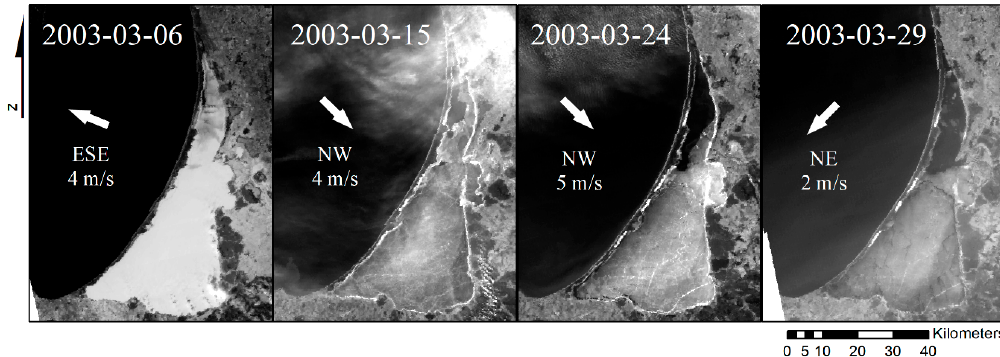
Figure 4. MODIS images of the ice cover retreat in the northern Curonian Lagoon during the winter of 2002–2003. Labels and arrows indicate the wind speed and direction.